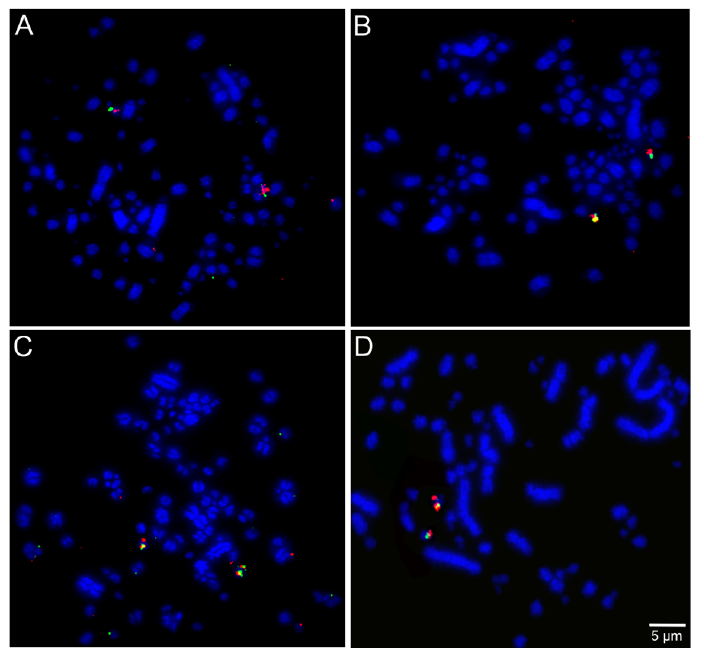
Figure 4. Examples of FISH experiments using chicken or zebra finch BAC probes in Pteroglossus